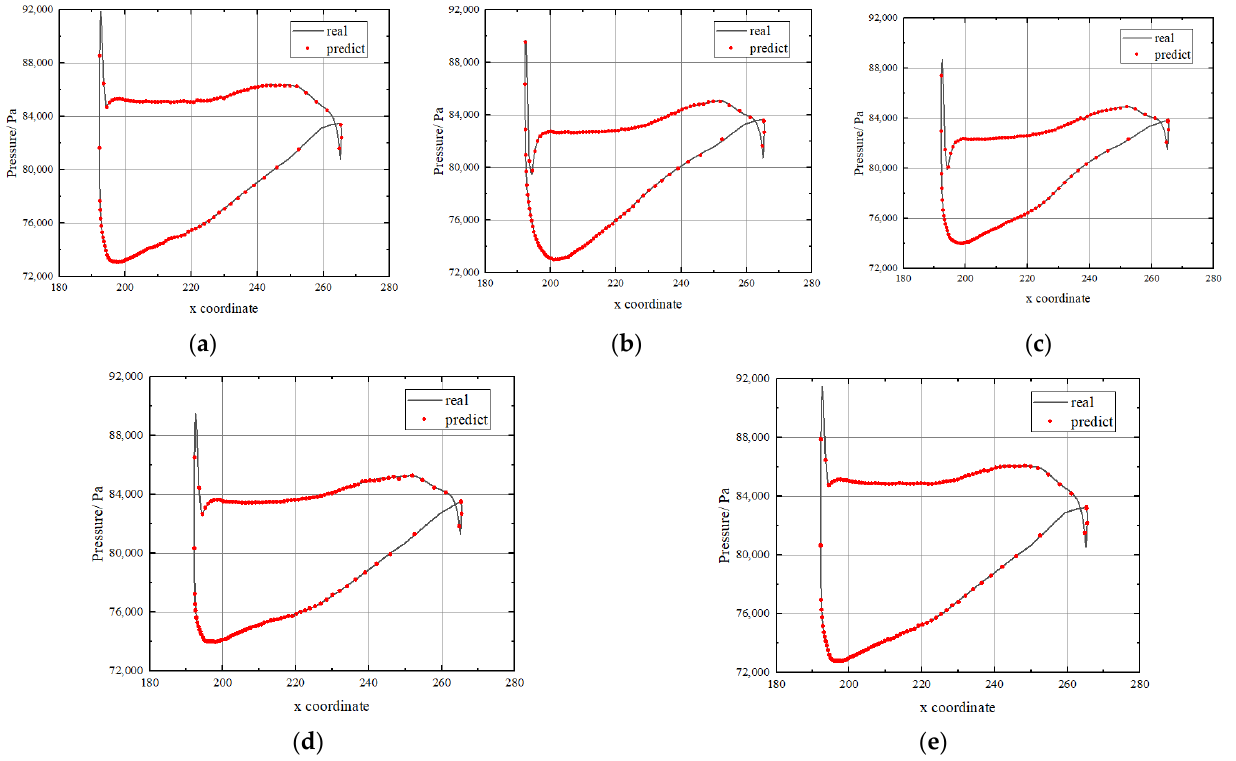
Figure 8. Unsteady pressure on stator surface at 10% span. ( a ) t = 0. ( b ) t = 1/4T. ( c ) t = 1/2T. ( d ) t =3/4T. ( e ) t = T.